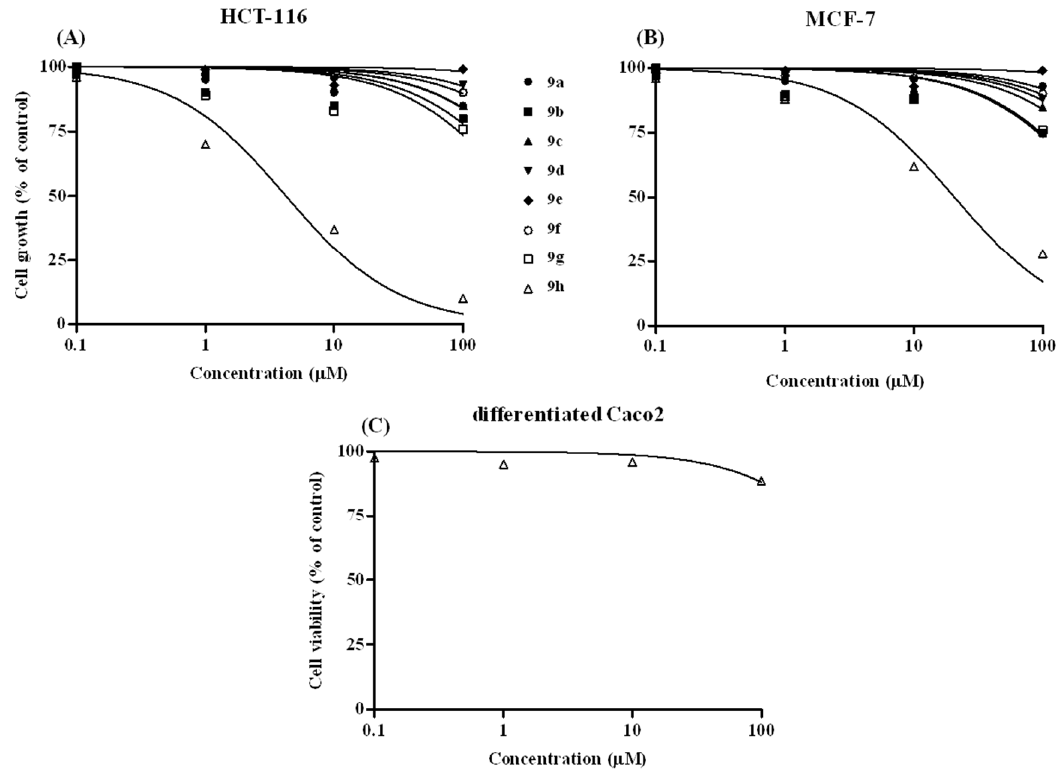
Figure 1. Effect of the synthesized tripentones 9a – h on the growth of human tumor cells HCT-116 ( A ) and MCF-7 ( B ) and of the active 9h derivative on the viability of intestinal normal-like differentiated Caco-2 cells ( C ). Cells were treated with the compounds and cell viability was measured after 72 h by MTT assay in comparison to cells treated with vehicle alone (control). Values are the means of three separate experiments performed in triplicate.